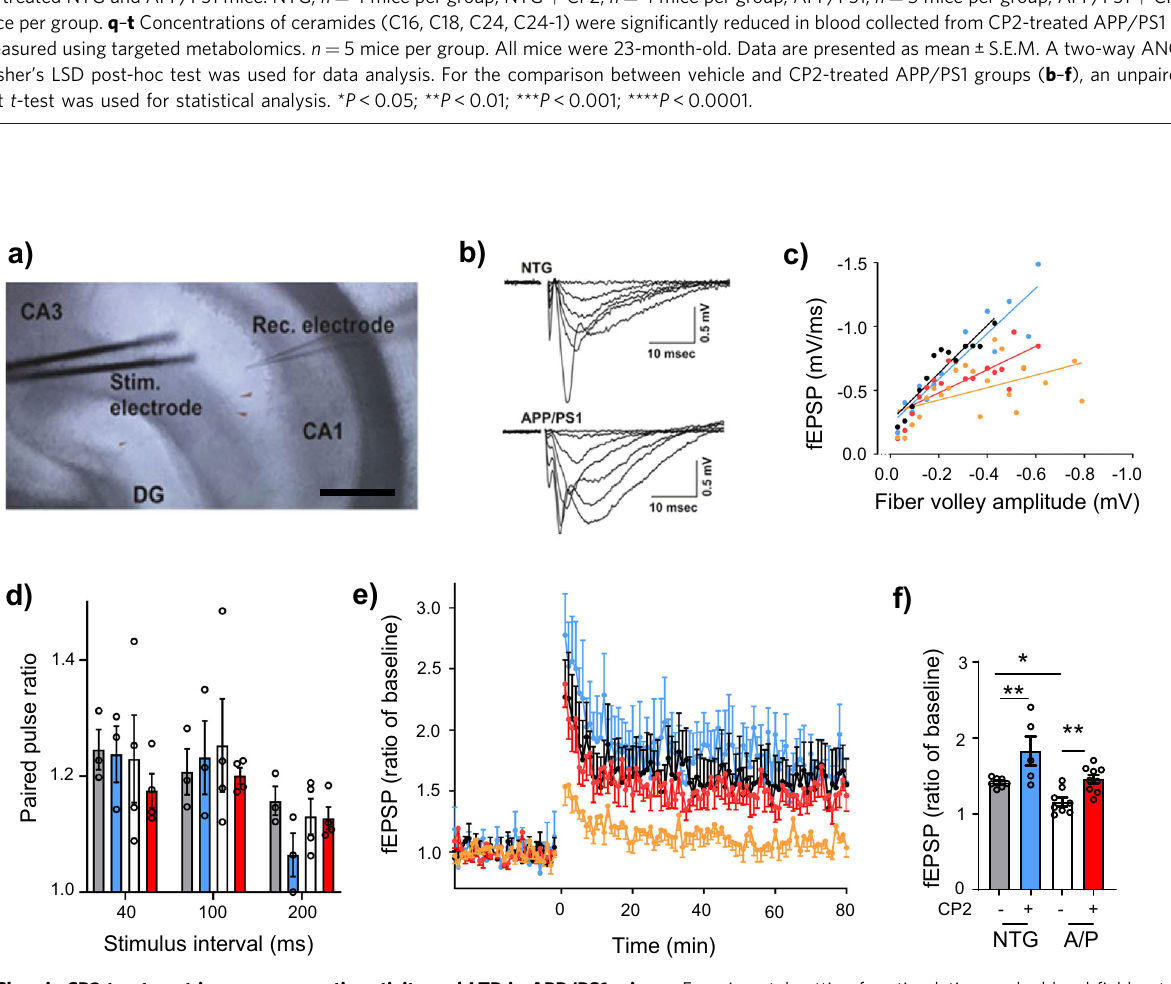
Fig. 5 Chronic CP2 treatment improves synaptic activity and LTP in APP/PS1 mice. a Experimental setting for stimulation-evoked local fi eld potential (LFP) measurement in the hippocampal slice. The stimulation (Stim) electrode was placed at the Schaffer collaterals and the recording (Rec) electrode was placed at the stratum radiatum in the CA1. Scale bar, 200 µ m. b Representative raw traces of fEPSP from NTG and APP/PS1 mice. Various stimulation intensities (10 – 300 µ A) were applied to evoke fEPSP. The stimulation pulse width and intervals were fi xed at 60 µ s and 30 s, respectively. As the stimulation intensity was increased, the initial slope of fEPSP was increased. c CP2 effect on basal synaptic strength. To examine the pre-post synaptic relationships, initial slopes of fEPSP were plotted against amplitudes of presynaptic fi ber volleys. Pre-post synaptic relationship in the CP2-treated APP/PS1 group was improved compared to the APP/PS1 group. d Paired-pulse facilitation did not differ between experimental groups. Two stimulations were applied with a short interval to determine presynaptic involvement in synaptic plasticity. e CP2 treatment improves LTP formation. Average traces for fEPSPs in hippocampal slices from each experimental group ( n = 2 – 3 slices from 5 mice per group). Traces represent mean ± S.E.M. per time point. To induce LTP, three tetanic stimulations (100 Hz, 60 µ s-pulse width for 1 s) were applied with 3-sec intervals. In APP/PS1 hippocampus, the tetanic stimulation induced early phase post-tetanic potentiation; however, long lasting potentiation was not observed. In the slices from APP/PS1 CP2-treated mice, LTP was induced and maintained over 60 min. NTG, black line; APP/PS1, orange line; NTG + CP2, blue line; APP/PS1 + CP2, red line. f LTP intensities among groups were compared at 60 min ( n = 3 slices from 5 mice per